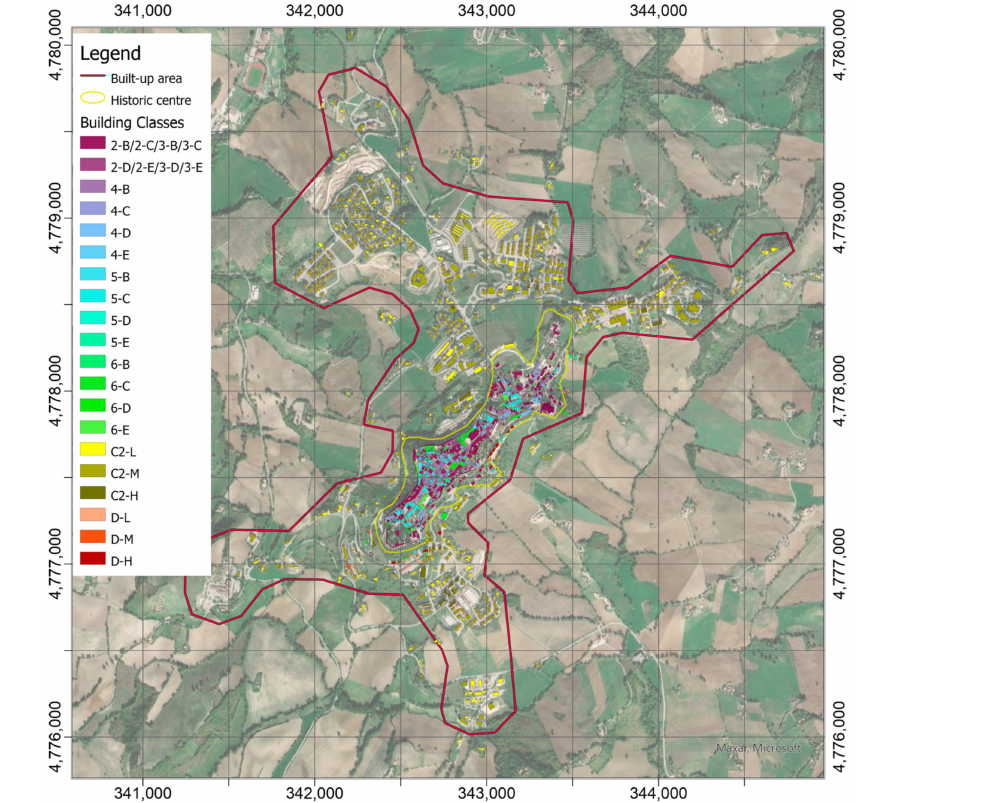
Figure 11. Classes attributed to the buildings in the built-up area of Camerino according to Table 1, by using their properties currently stored in ARCH HArIS. The most vulnerable class was attributed to the unclassified buildings: 2/3-B/C for those in the historic center and C2-M,L,H for the external ones, depending on their height above